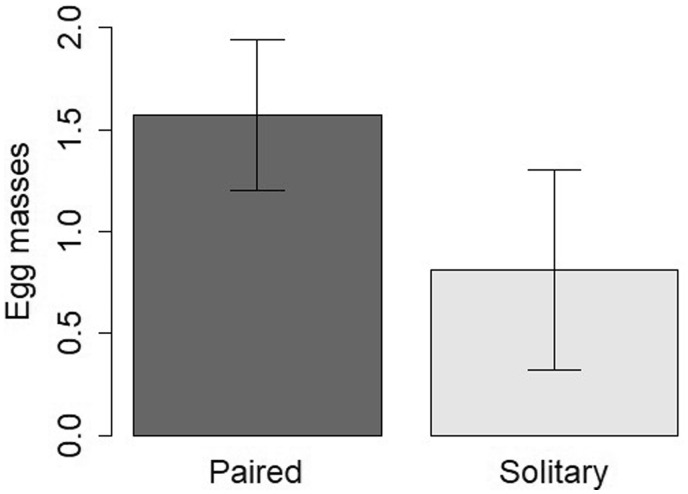
Mean number of egg masses produced by paired (n = 56) and solitary (n = 21) S. gigas over four reproductive cycles. Error bars indicate 95% confidence intervals.